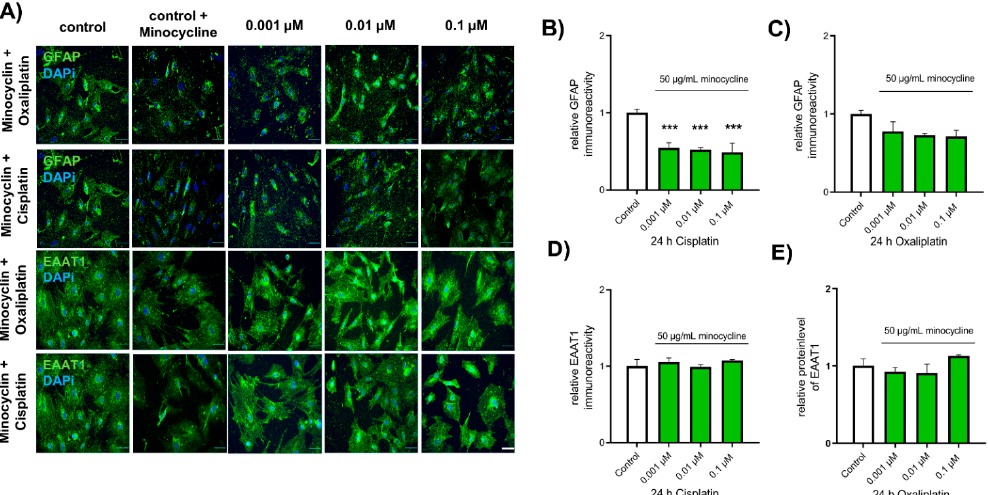
Figure 6. Influence of antibiotic minocycline on the expression of GFAP and EAAT1 in cultured spinal astrocytes. ( A ) Immunocytochemical staining of GFAP or EAAT1 (green) in cultured spinal astrocytes before or after exposure to minocycline and cis- or oxaliplatin. Nuclear DNA was stained with Dapi (blue). ( B ) When spinal astrocytes were pre-exposed to minocycline, cisplatin reduced the expression of GFAP compared to untreated control cells (*** p < 0.001). ( C ) When spinal astrocytes were pre-exposed to minocycline, oxaliplatin did not affect the expression of GFAP compared to untreated control cells ( p > 0.05). ( D , E ) Cis- or oxaliplatin did not affect the expression of EAAT1 when spinal astrocytes were pre-exposed to minocycline ( p > 0.05). * = significant difference to control. n = 9 experiments with each >100 cells. Scale 50 µ